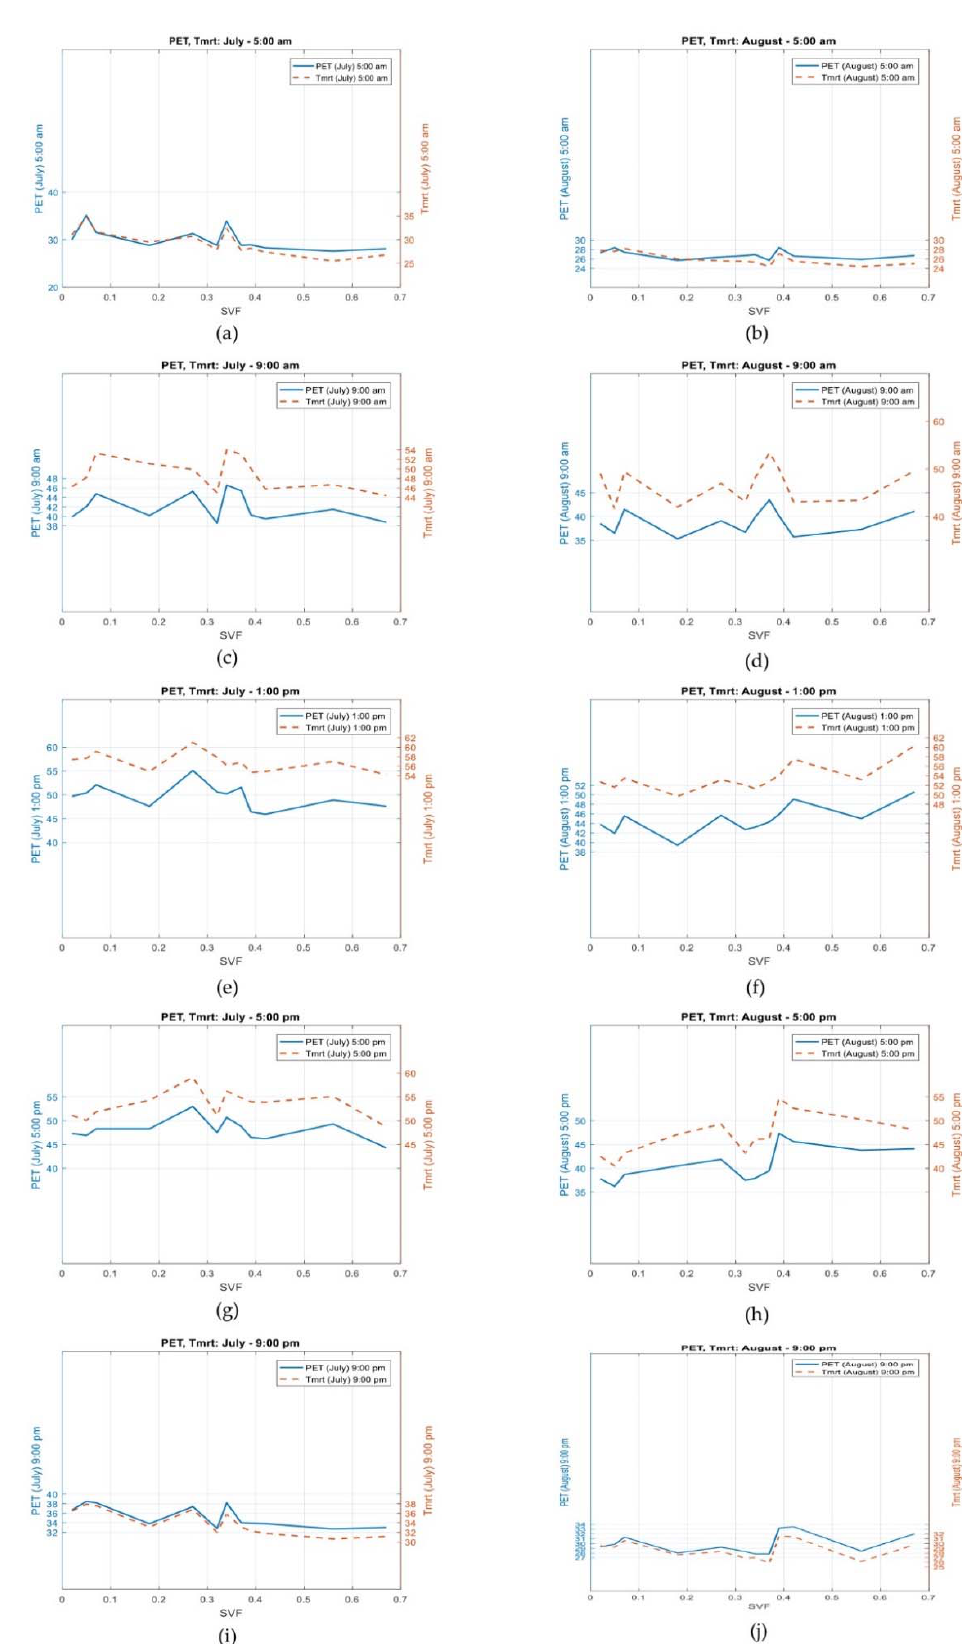
Figure 6. Variations between PET and Tmrt values depending on the SVF during July and August 2018: ( a , c , e , g , i ) are July variations; ( b , d , f , h , j ) are August variations.